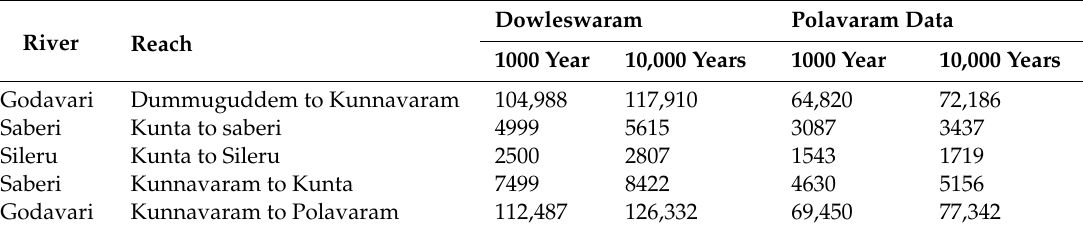
Table 5. Goodness of fit test (Chi-square test) for probability distributions along with rank. At Dowleswaram At Polavaram Distribution Rank Rank Gamma 8 4 Gen. Extreme Value 3 2 Lognormal (3P) Log-Pearson 3 Normal Pearson 5 (3P)